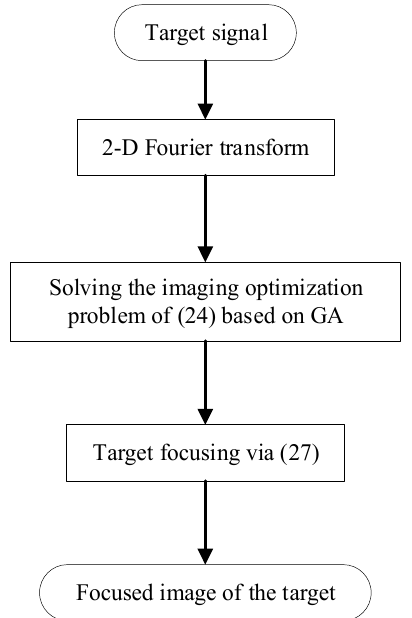
Figure 4. Flowchart of the proposed imaging method.